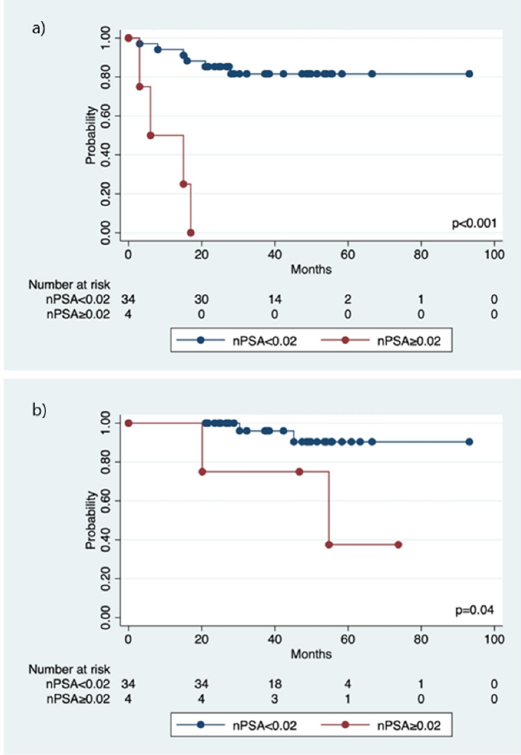
Figure 3. The cumulative 5-year biochemical progression free survival ( a ) and overall survival ( b ) for